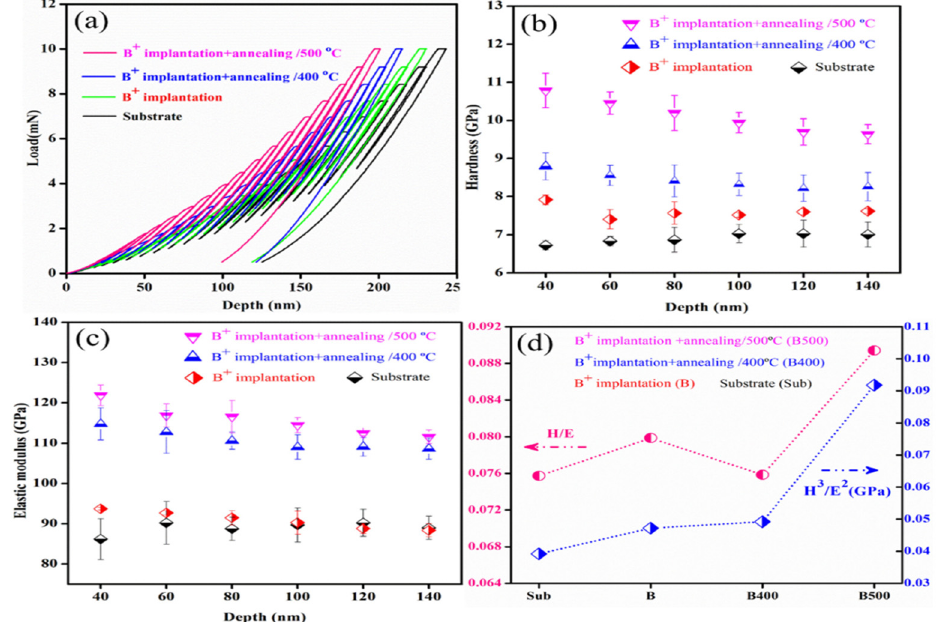
Figure 6. Mechanical properties of the untreated and as-treated 60NiTi surface: ( a ) load–displace- ment curves; ( b ) hardness (H); ( c ) elastic modulus (E); ( d ) H/E and H 3 /E 2 . (Reprinted from Tribology International, 155, C. Yan, Q. Zeng, W. He, and J. Zhu, Enhanced surface hardness and tribocorrosion performance of 60NiTi by boron ion implantation and post-annealing, 106816, Copyright (2021), with permission from Elsevier.)